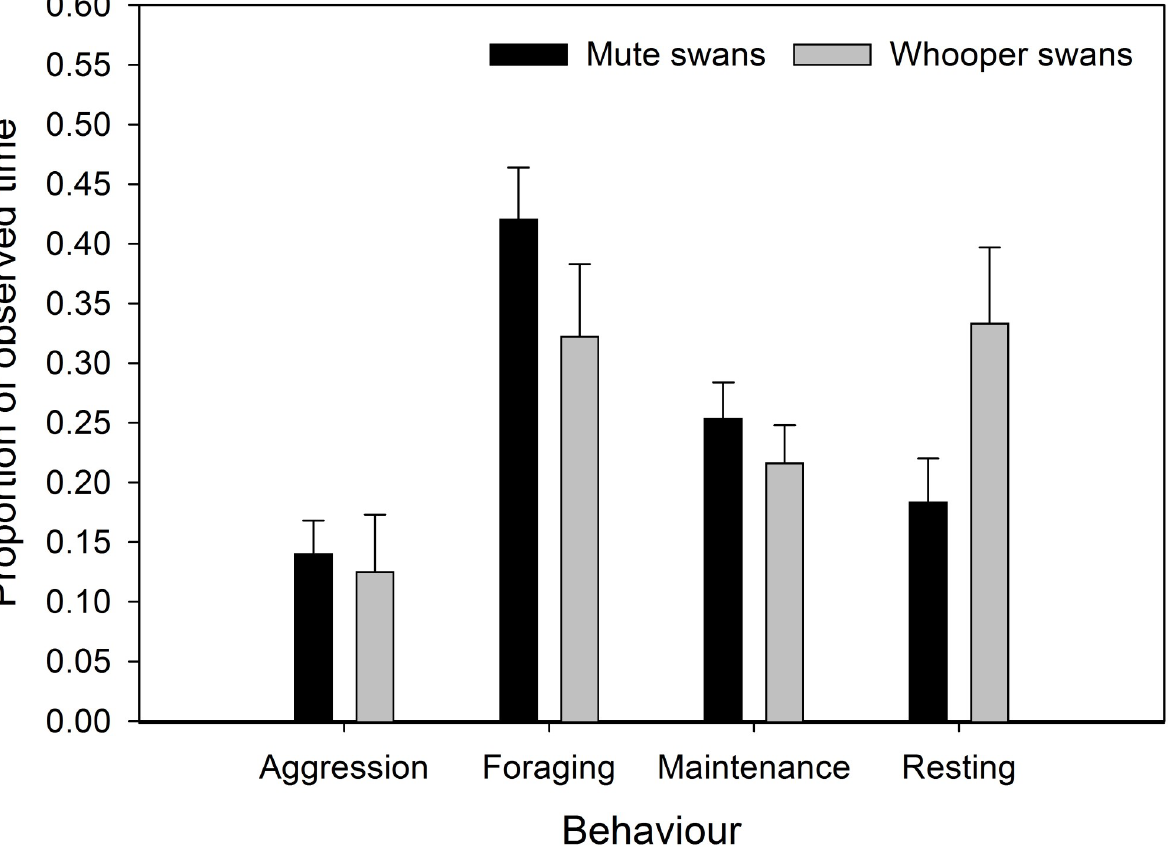
Fig 1. Time-activity budgets. The mean ( ± 95% CI) proportion of observed time that mute swans (black bars; n = 81) and whooper swans (grey bars; n = 38) spent on each behaviour.